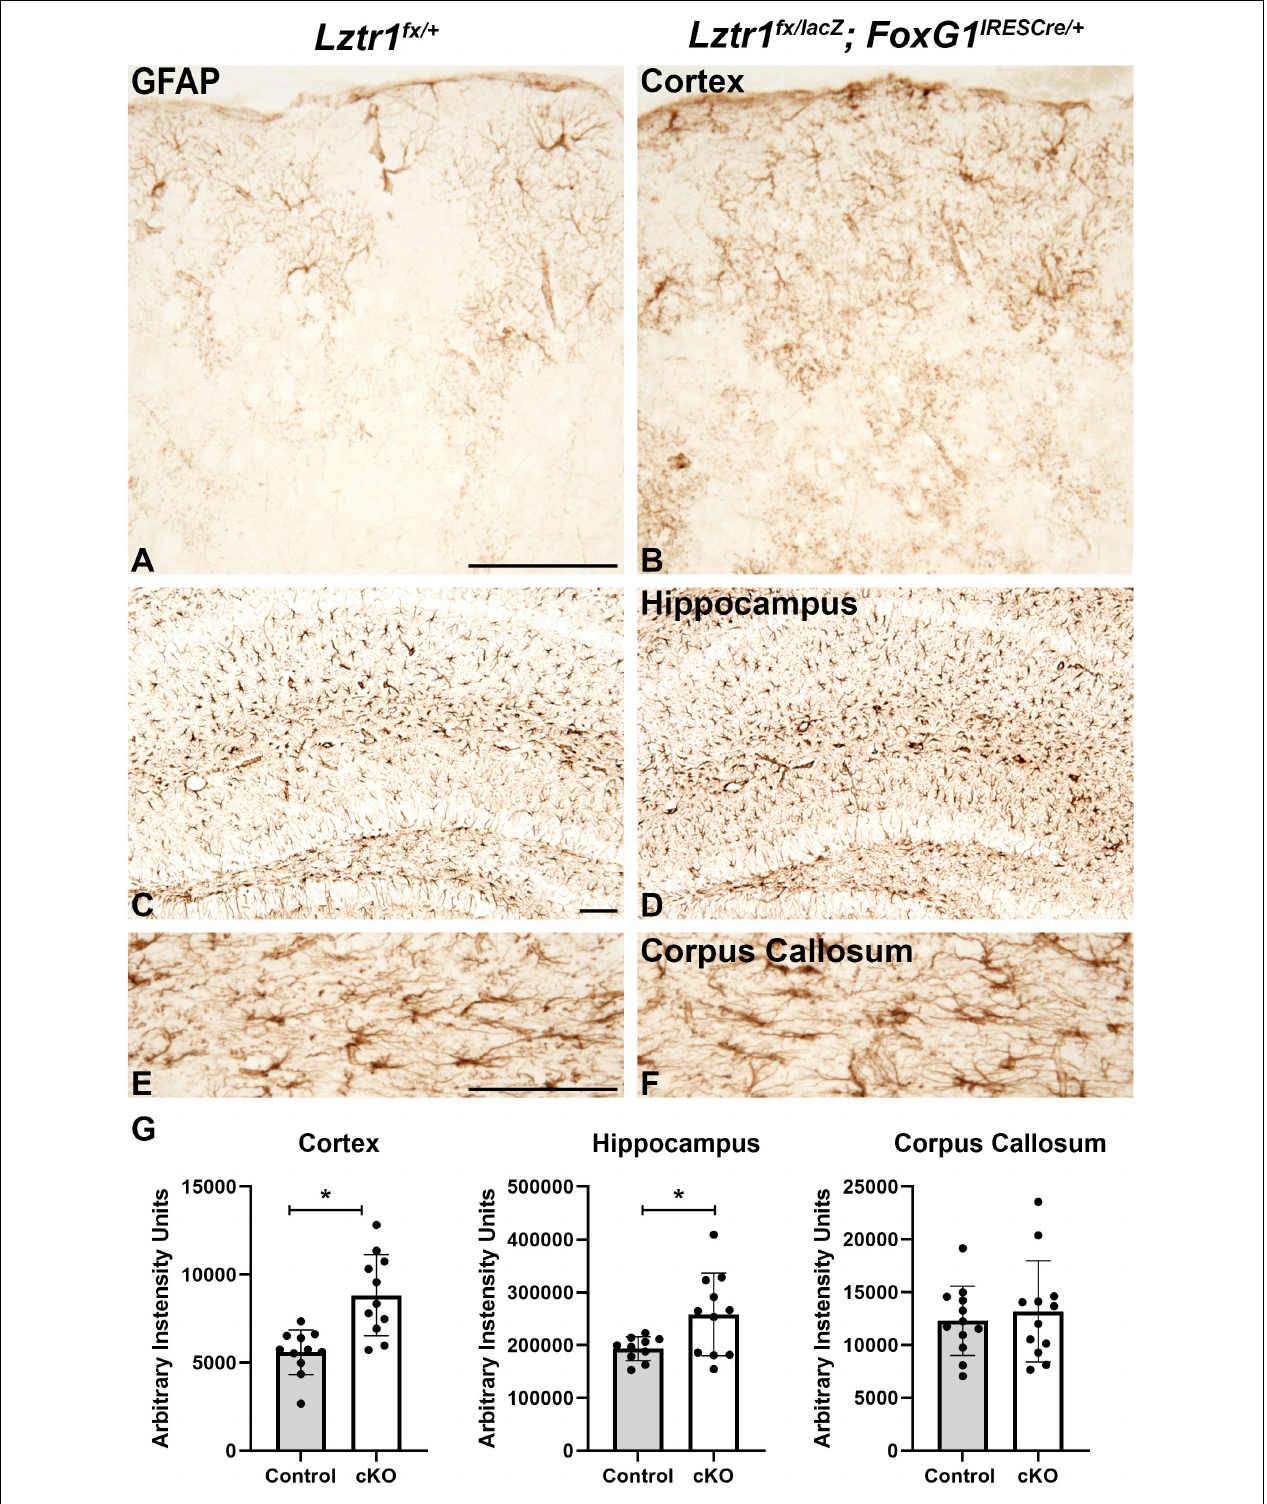
FIGURE 4 | Loss of Lztr1 increases the expression of the astrocyte marker GFAP in postnatal animals at 1 month of age. Increased GFAP as measured by stain intensity (arbitrary intensity units) is observed in the cortex and hippocampus of cKOs compared to controls (A–D,G) . The GFAP expression in the corpus callosum was similar in cKOs compared to controls (E,F) . Quantification (G) . Scale bars = 100 µ m for (A–F) . The asterisk in (G) refers to a p < 0.05 as detected by Student’s t -test.